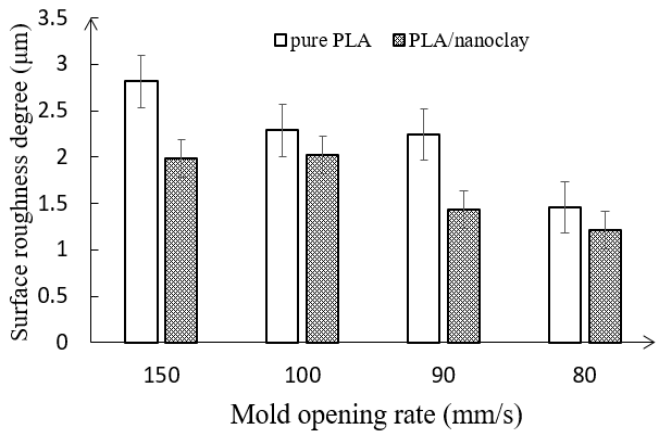
Figure 7. Variation of the surface quality of pure PLA and PLA–nanoclay foamed samples with various mold opening rate.